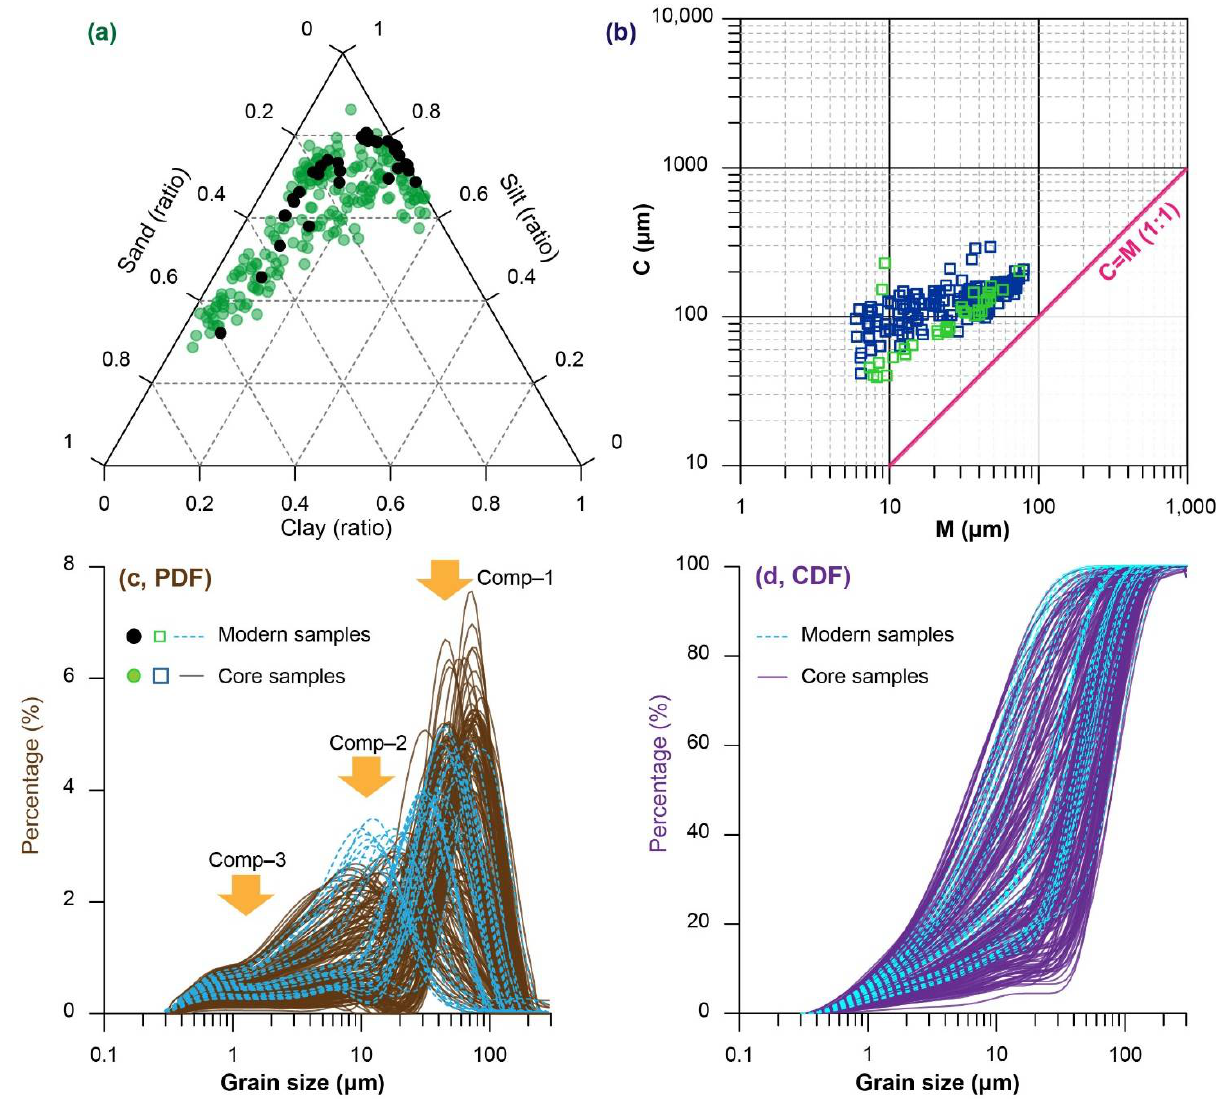
Figure 3. Characteristics of sediment grain size of core YDZ–3 and 35 surface samples. ( a ) Ternary diagrams; ( b ) C–M diagrams; ( c , d ) Grain-size distributions, PDF: probability density function, CDF: cumulative distribution function. Comp–1, –2, and –3 are three components by mathematical unmixing in Figure 4.